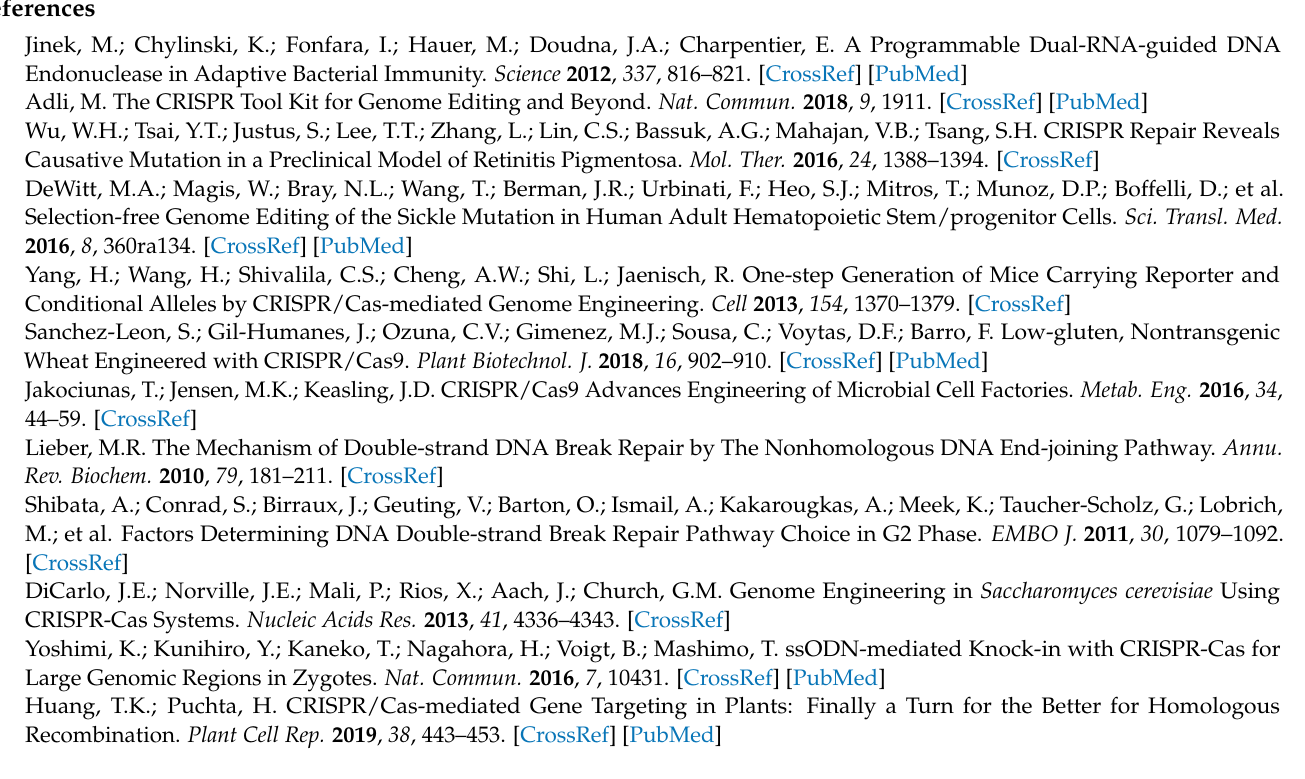
gene edited by DGybrid-based genome editing, Figure S2: Growth of Cas9-expressing yeast cells electroporated with nucleic acid solutions, Figure S3: Evaluation of the effect of various DGybrid designs on genome-editing efficiency, Figure S4: Native-PAGE analysis to confirm DNA/RNA hybrid formation, Figure S5: Density plots obtained from flow cytometry analysis. Table S1: List of primers used in this study, Table S2: List of RNA and ssODNs used in this